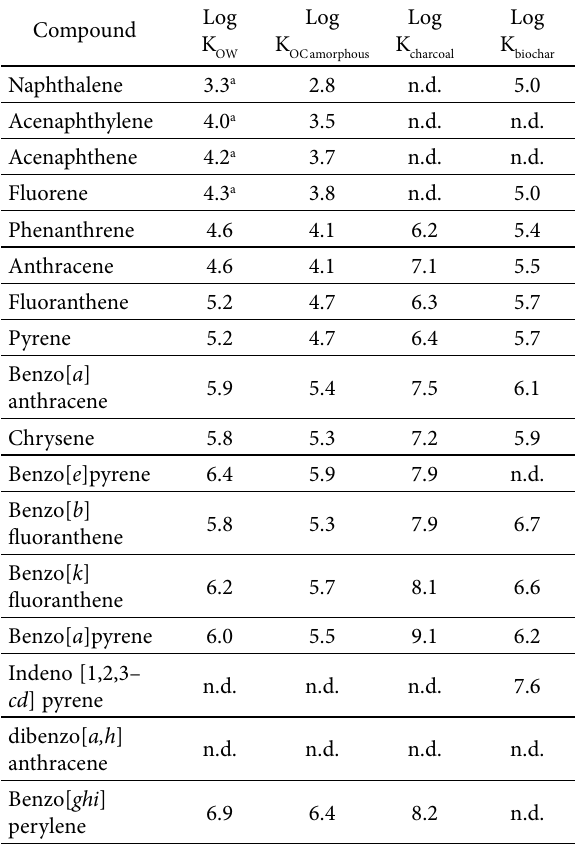
Table 2. PAH octanol-water (K (Jonker, Koelmans 2002) (numbers without footnote), organic carbon-water (K black carbon calculated (K